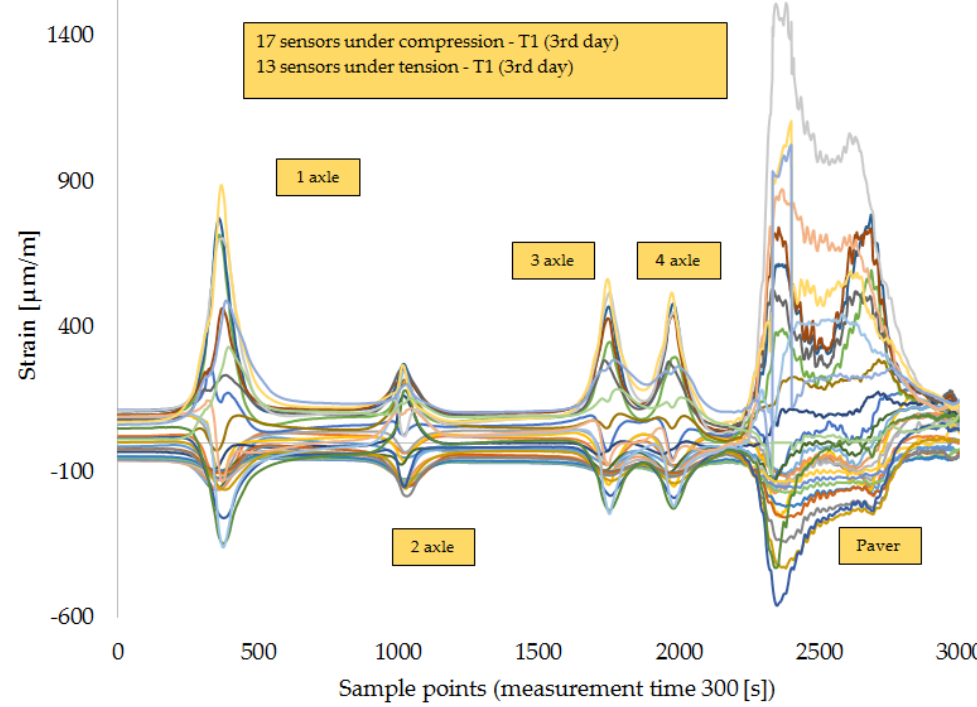
Figure 14. Monitoring of T1 on the third day of the paving process when the four-axle truck and the paver drove along the FBG chain of 30 DTG ® (L1) embedded under the first base asphalt layer (AC-14) [17].